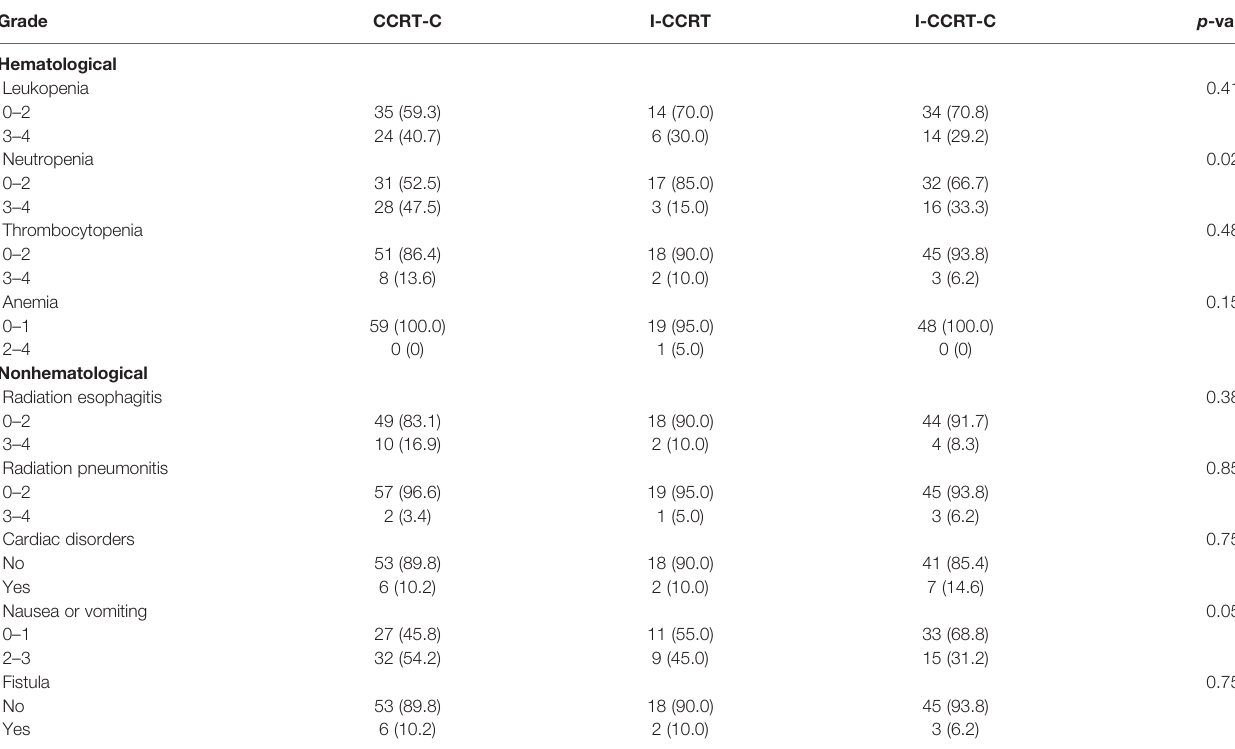
TABLE 5 | Adverse events related to de fi nitive chemoradiotherapy [ n (%)].